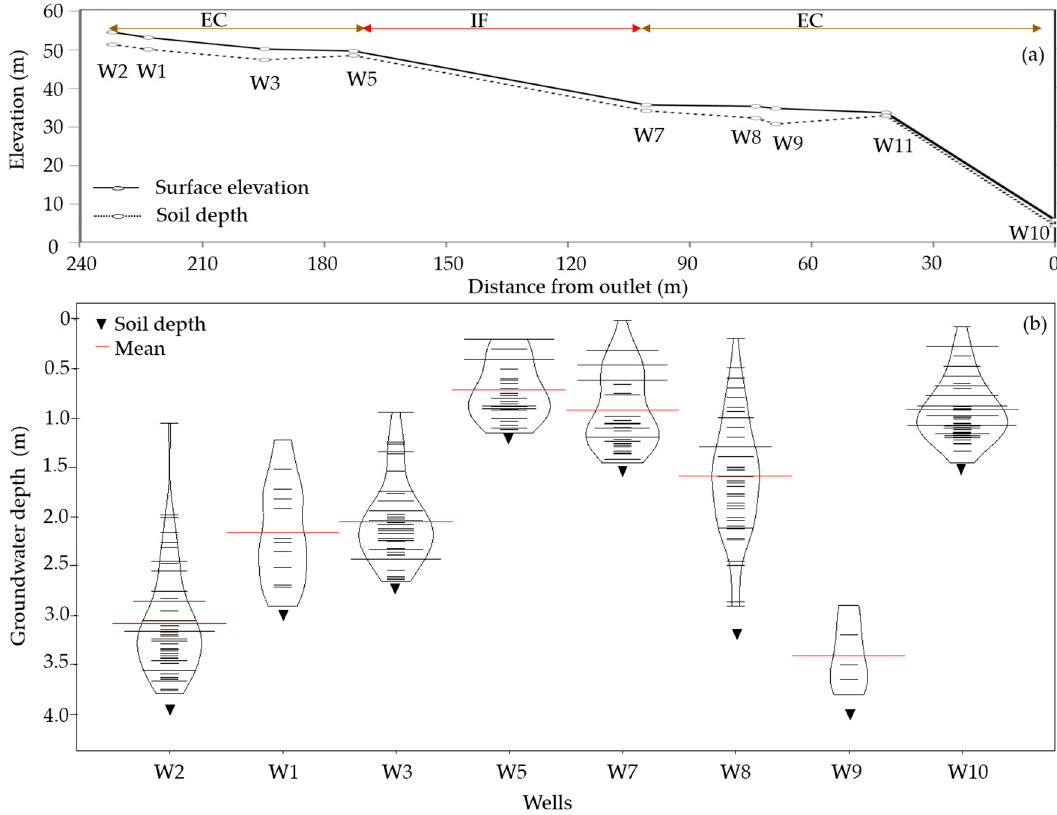
Figure 9. ( a ) Longitudinal profile of the main channel and measured soil depth. The ephemeral (EC) and intermittent flow (IF) parts are highlighted. The solid line connecting the wells is for illustration purposes as the wells follow the slope but are not located exactly in the channel. ( b ) Measured and maximum event groundwater levels (the y-axis is not in scale with the topography). The polygon shape in the bean plot is given by a normal density distribution. Each black line is a measured data. The width of a line is proportional to the measurement count. Wells W4, W6, and W11 are not shown. The black triangles indicate the approximate depth to the bedrock.